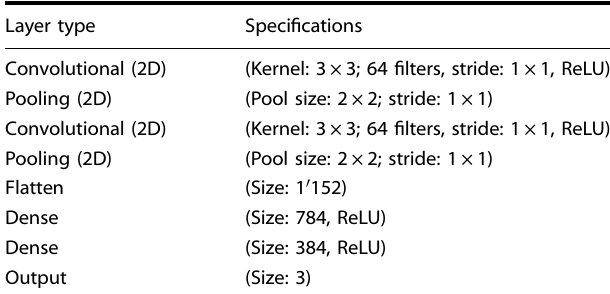
Table 1. EulerNet model layer speci fi